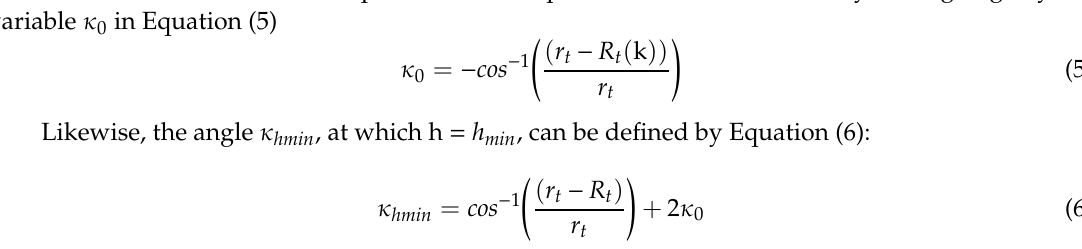
Figure 3. Geometry of the uncut chip in turning, milling and grinding, including sideflow effects.